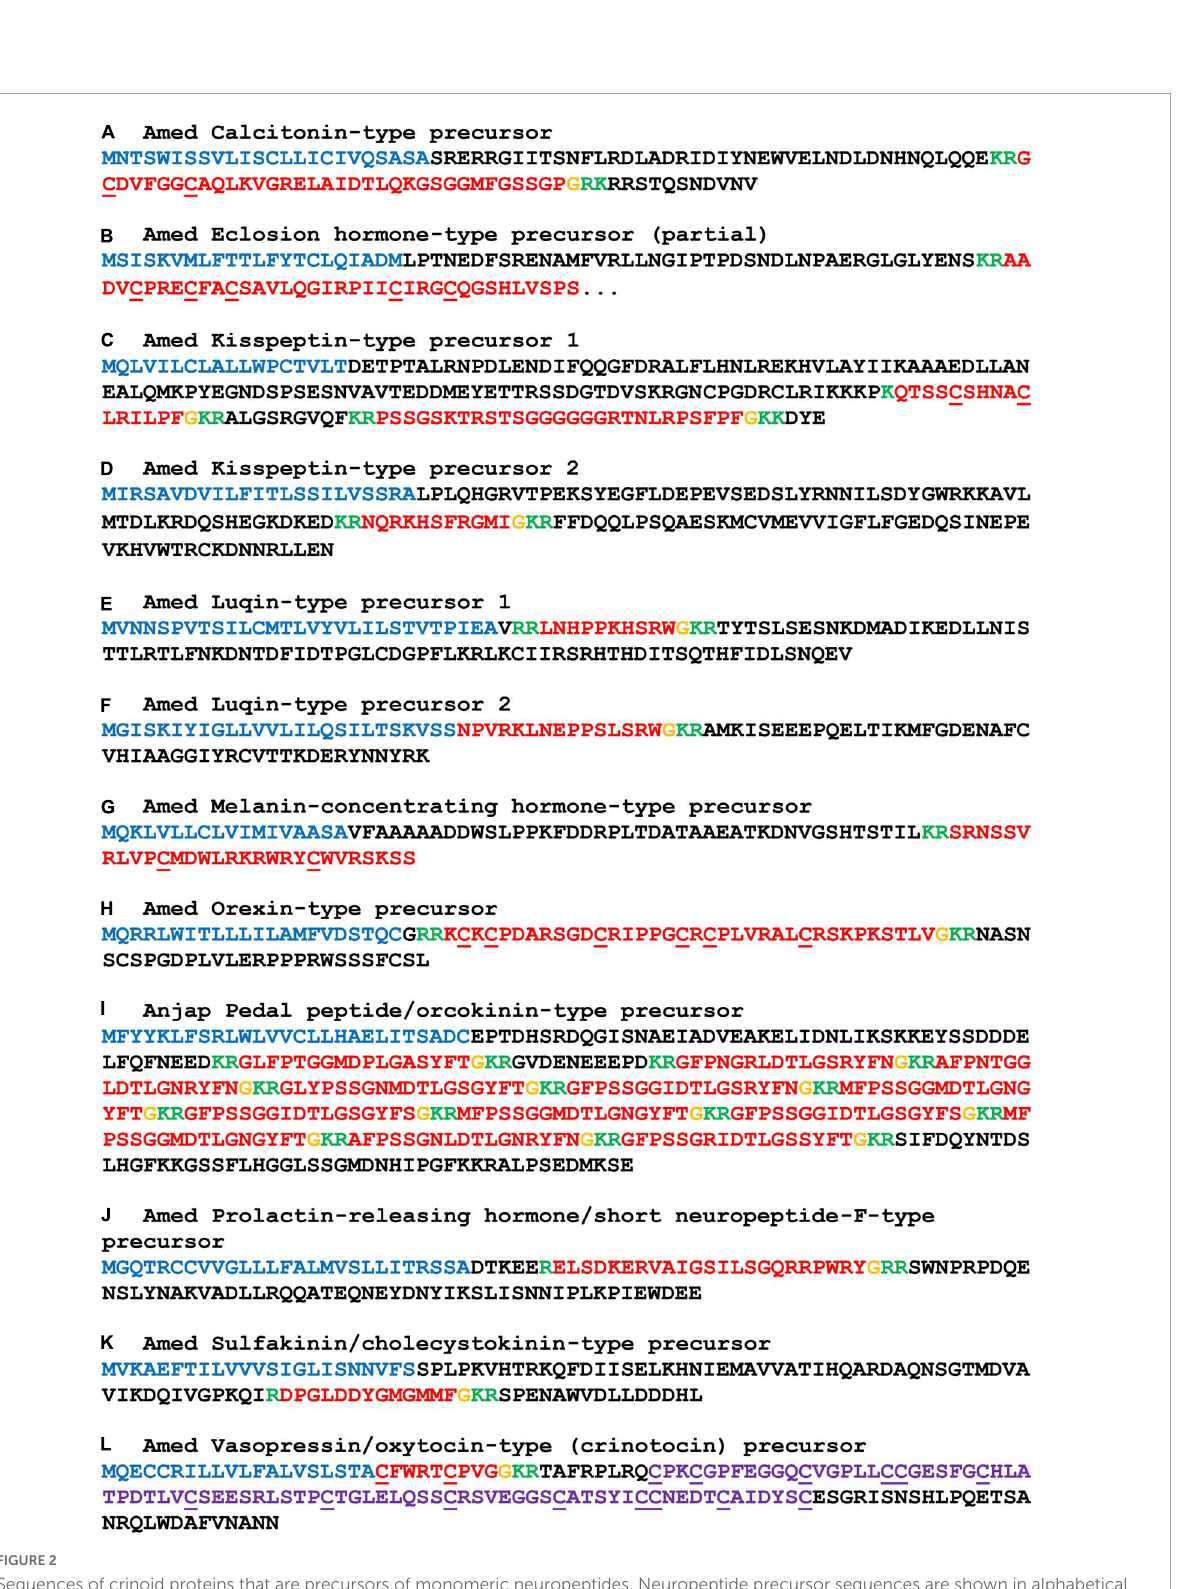
FIGURE2 Sequences of crinoid proteins that are precursors of monomeric neuropeptides. Neuropeptide precursor sequences are shown in alphabetical order and are from Antedon mediterranea (Amed), with the exception of pedal peptide/orcokinin-type precursor which was not identified in this species but which was identified in Anneissia japonica (Anjap). The predicted signal peptide is shown in blue, predicted monobasic/dibasic cleavage sites are shown in green and predicted neuropeptides are shown in red, but with C-terminal glycine residues that are potential substrates for post-translational amidation shown in orange. The underlined cysteine residues have been shown to form intramolecular disulphide bridges in homologous monomeric neuropeptides in other taxa. The neurophysin domain of the vasopressin/oxytocin-type (crinotocin) precursor is shown in purple. The DNA sequences of transcripts encoding these precursors are shown in Supplementary File 2